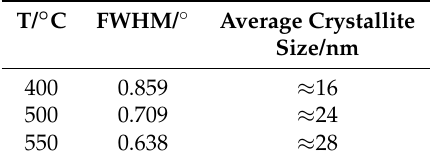
Table 1. Analysis of anatase (101) GI-XRD peak broadening of single-layered MTTFs calcined at different